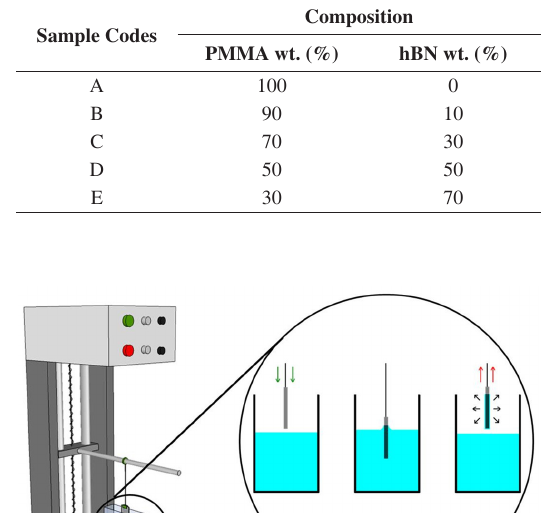
Table 1. Specification of PMMA/hBN composite coatings.